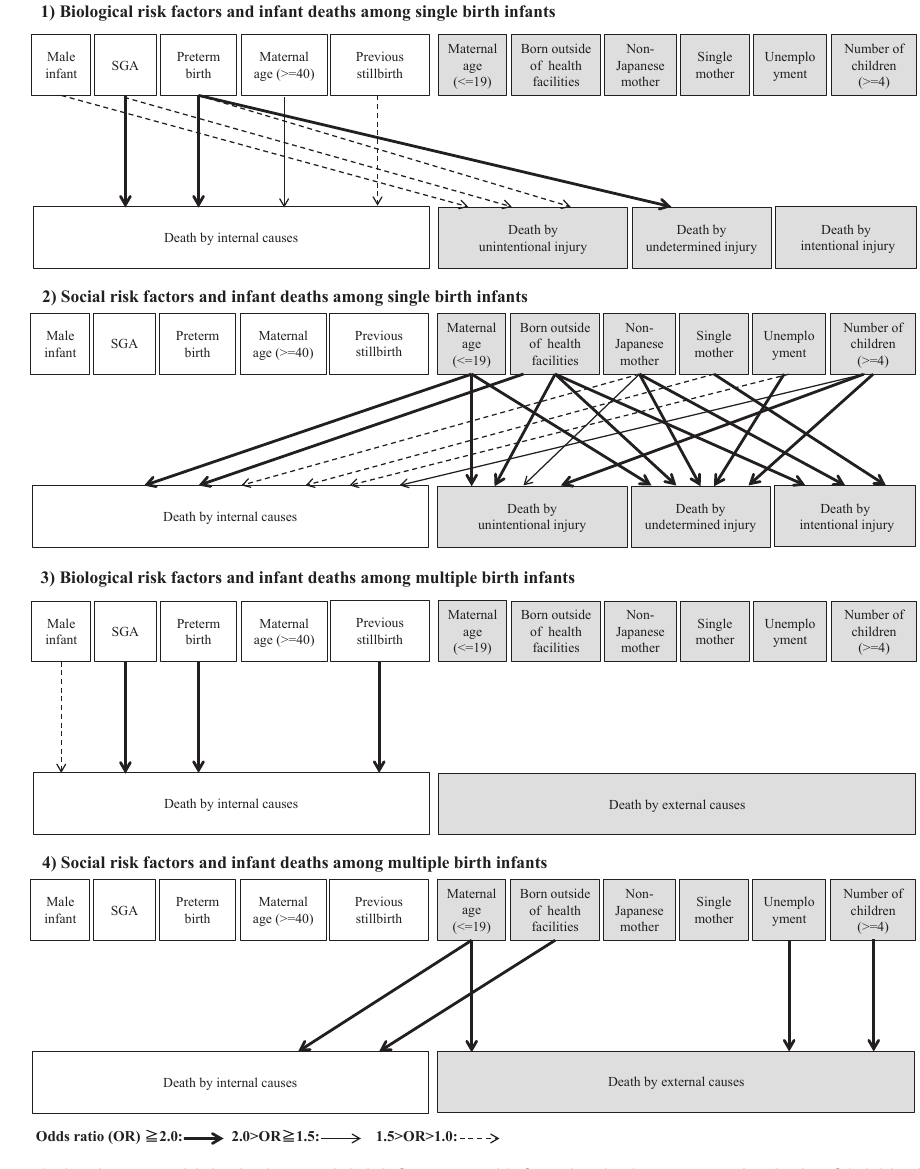
Figure 1. Association between biological or social risk factors and infant deaths by causes. Analysis of 8,941,501 infants born in Japan in 2003 –